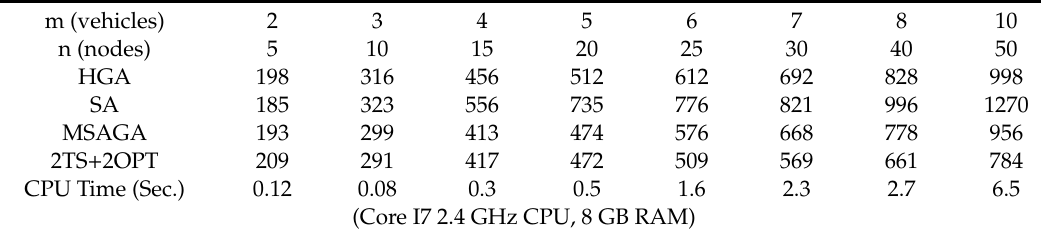
Table 1. Distance comparison of 2TS + 2OPT to the other three